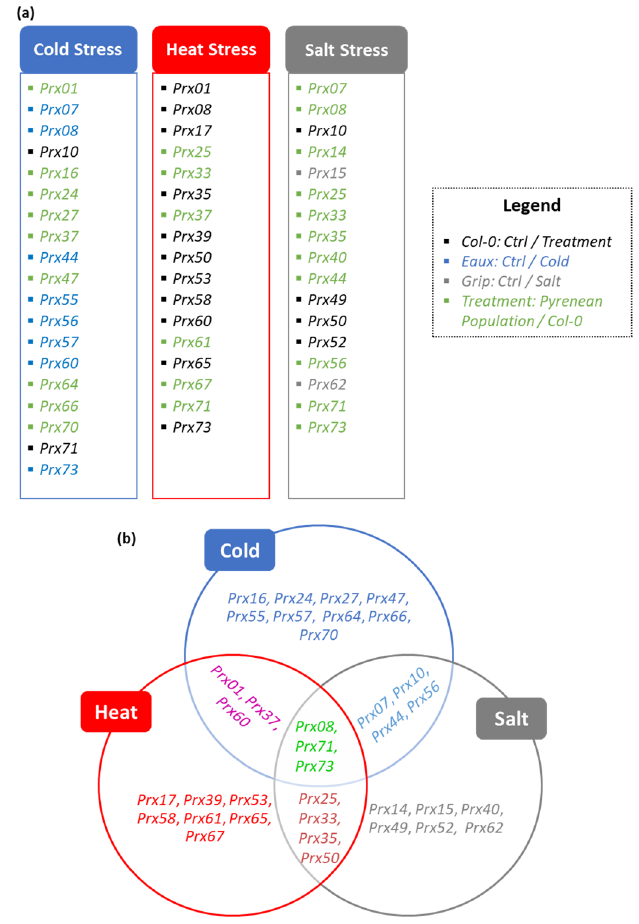
Figure 7. ( a ) Lists of significantly upregulated CIII Prxs under cold, heat, and salt stresses that were highlighted by the DE analyses, including genes that were identified by treatment-based comparisons to the ctrl condition in Col-0 (black), by treatment-based comparisons of cold stress to the control in Eaux (blue) and of salt stress to the control in Grip (grey), and by genotype-based comparisons of a Pyrenean population to Col-0 under the different treatments (green). ( b ) Functional specification of different CIII Prxs in response to various abiotic stresses that were identified in Col-0 (not-highlighted) and the Pyrenean populations (green